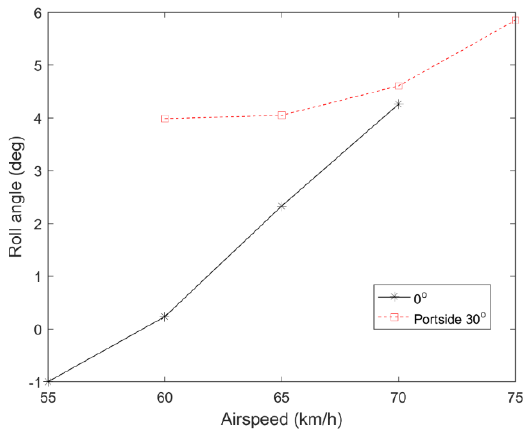
Figure 16. Trim roll angle under 0° and portside 30° WOD conditions.